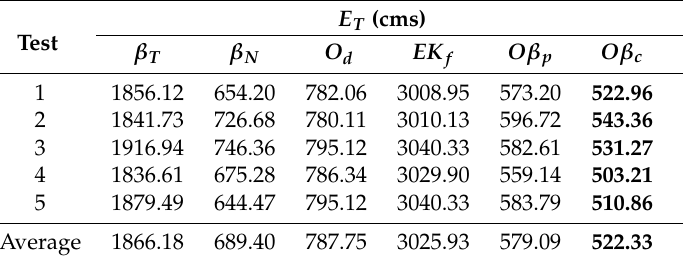
Table 5. Localization error for Trajectory 3. The least error for each row is written in bold.